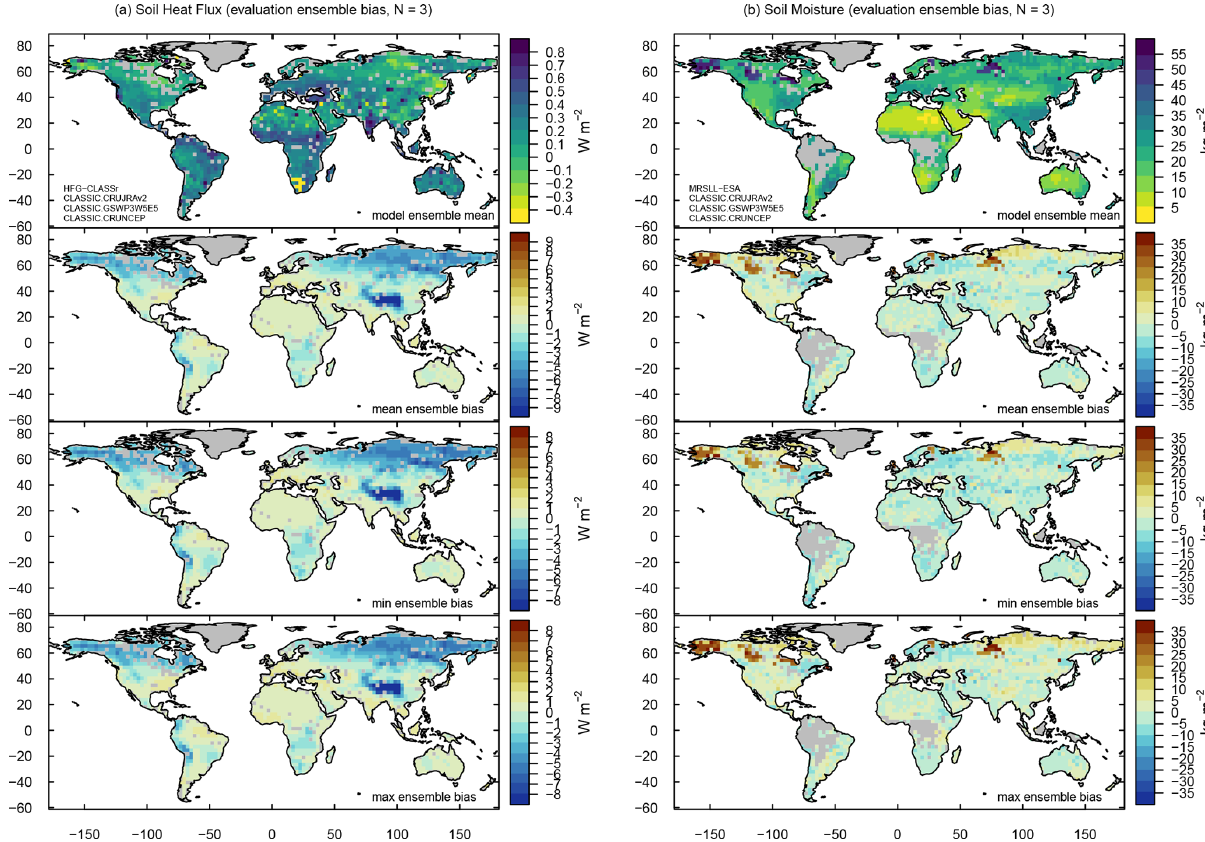
Figure A8. Same as Fig. 7 but for (a) soil heat flux and (b) soil moisture in the top 10 cm.